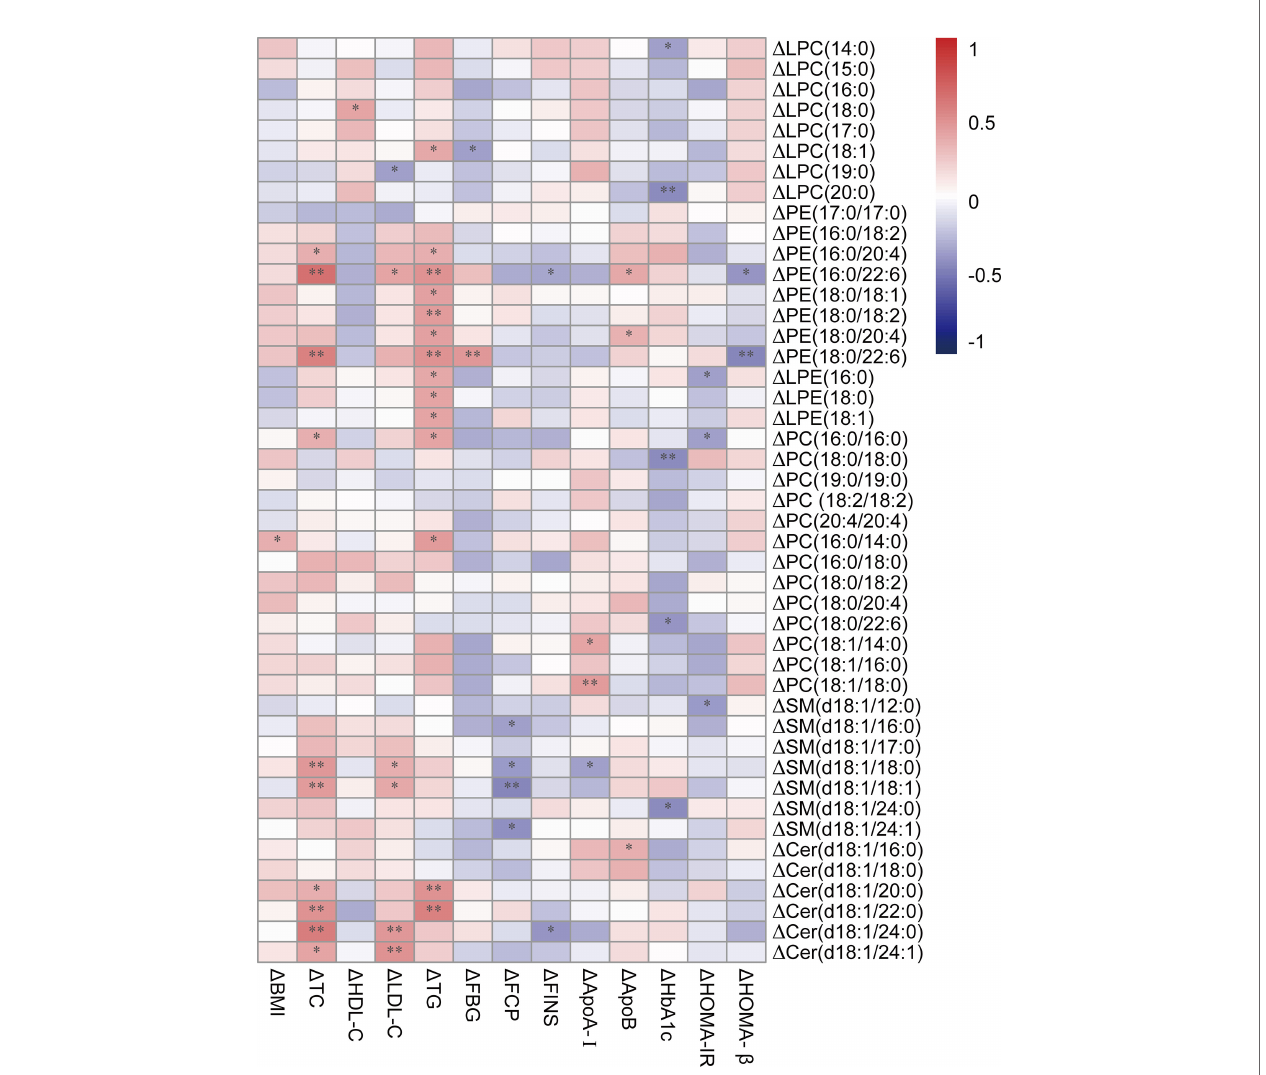
FIGURE 4 | Correlation heatmap between differences of down-regulated lipids and key clinical characteristics. A bipolar color progression with scales on the right of the fi gure represented positive correlation (red) and negative correlation (blue), respectively. Statistical signi fi cances are indicated by asterisks. * P < 0.05; ** P < 0.01. D means the differences of lipids or clinical parameters between before and after exenatide treatment. LPC, lysophosphatidylcholine; PE, phosphatidylethanolamine; LPE, lysophosphatidylethanolamine; PC, phosphatidylcholine; SM, sphingomyelin; Cer,